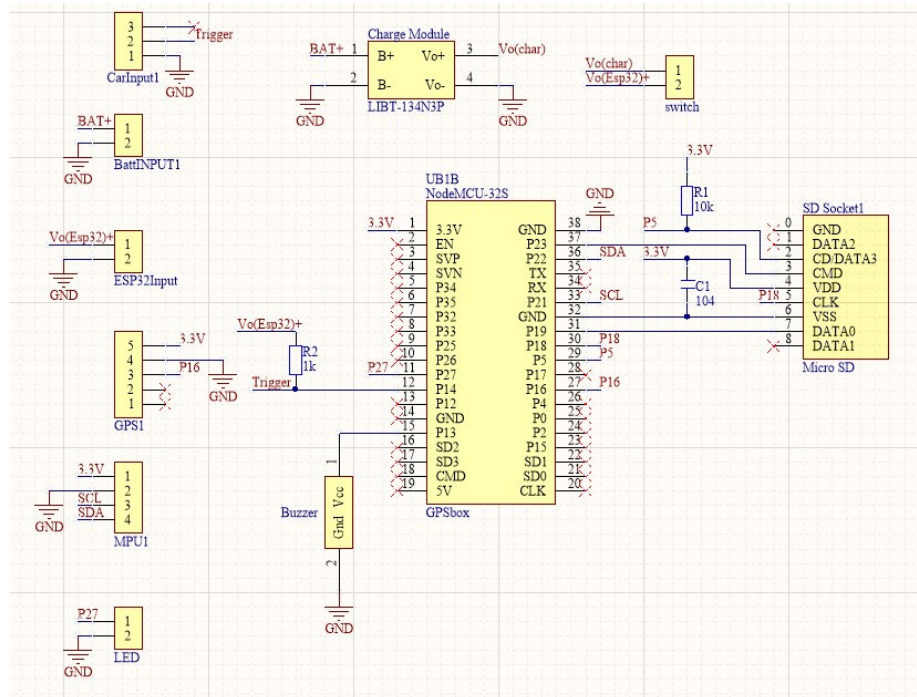
Figure 17. Set-top box circuit design.